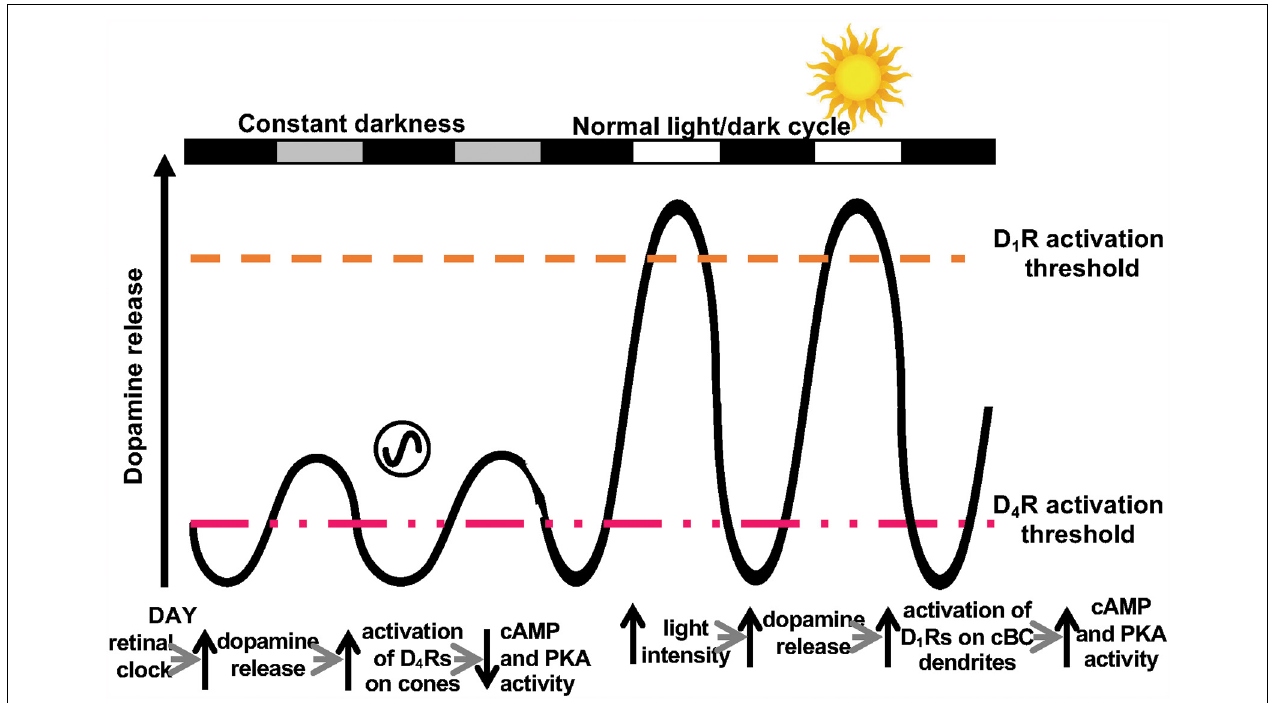
FIGURE 2 | Two dopamine receptor systems in the retina. Schematic representation of the dual control of dopamine release by the retinal circadian clock and light in the fish retina, which activate D 4 Rs and D 1 Rs, respectively. Although the retinal clock releases less dopamine in the day than bright illumination, circadian clock-induced dopamine release in the day is sufficient to activate cone D 4 Rs (but not D 1 Rs on cBCs and HCs), because D 4 Rs are ∼ 500 times more sensitive to dopamine than D 1 Rs. As a result, cAMP/PKA in cones is low in the day. In constant darkness at night, dopamine levels are lower than in the day and not sufficient to activate cone D 4 Rs. As a result, cAMP/PKA in cones increases at night. The circadian rhythm in dopamine release is due to the inhibitory action of melatonin on dopamine release. The retinal clock increases melatonin synthesis and release to a greater extent at night than in the day, which results in a circadian rhythm in dopamine release that is opposite in phase (i.e., higher in the day than at night). During the subjective day (SD), melatonin levels are low and as a result, so is its inhibitory action on dopamine release. Consequently, during the subjective day, extracellular dopamine levels increase sufficiently to activate D 4 receptors, but insufficiently to activate D 1 receptors. During the regular light/dark cycle, daylight increases dopamine release sufficiently to activate D 1 receptors. Modified from Ribelayga and Mangel